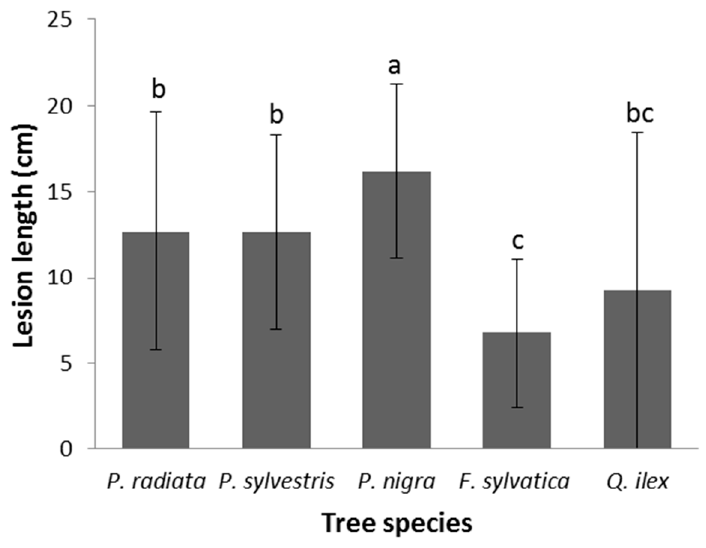
Figure 10. Length of lesions (cm) caused by A. mellea in different tree species. Error bars show the standard deviation of the means. Statistically significant differences of p < 0.05 between tree species are presented with different lowercase letters.